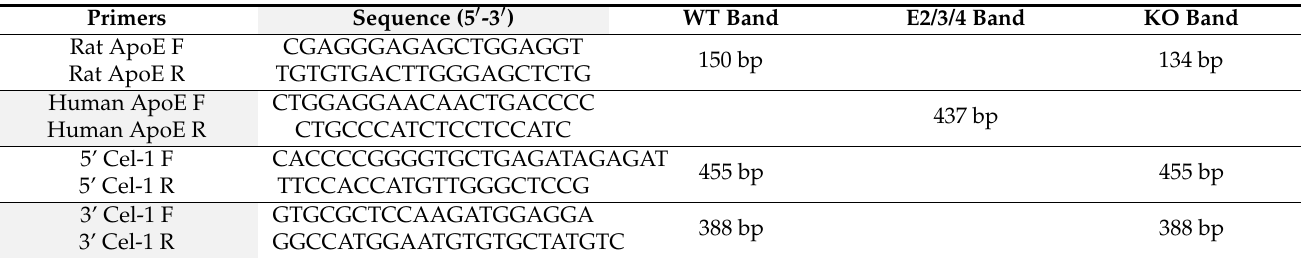
Table 2. Primers used for